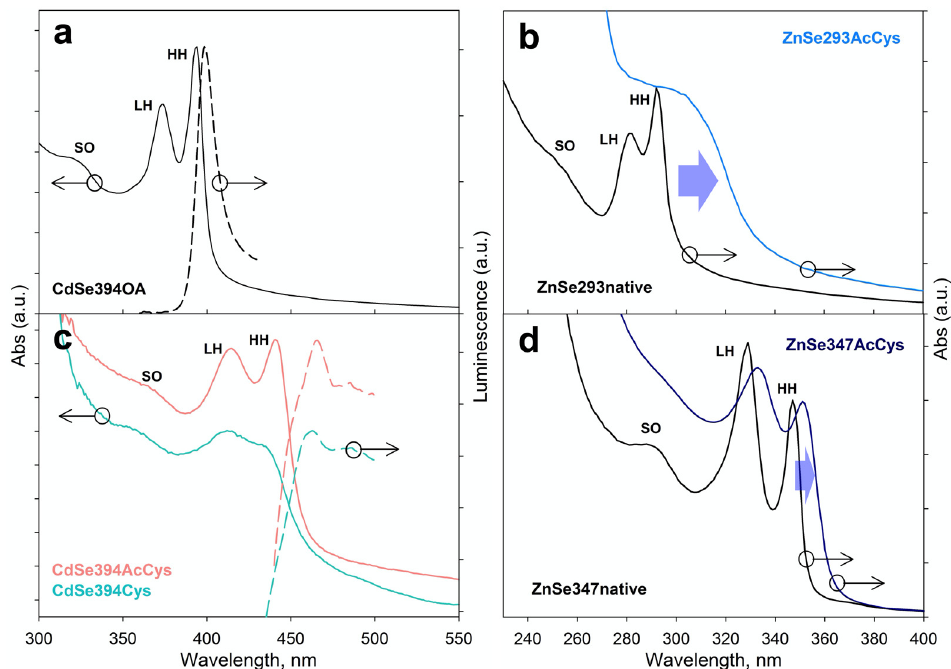
Figure 3. ( a ) Typical absorbance and luminescence spectra of CdSe394OA NPLs (black solid and dashed lines, respectively). ( b ) Absorbance spectra of ZnSe293OA NPLs (black dashed lines) and their modification after ligand exchange with AcCys ligands (ZnSe293AcCys, cyan line). ( c ) Modification of absorbance and luminescence spectra of CdSe394OA NPLs after ligand exchange with AcCys (CdSe394AcCys, pink lines) and Cys (CdSe394Cys, turquoise lines) ligands. ( d ) Absorbance spectra of ZnSe347OA NPLs (black dashed lines) and their modification after ligand exchange with AcCys ligands (ZnSe347AcCys, blue line). Blue arrows illustrate spectral shifts after ligand exchange.